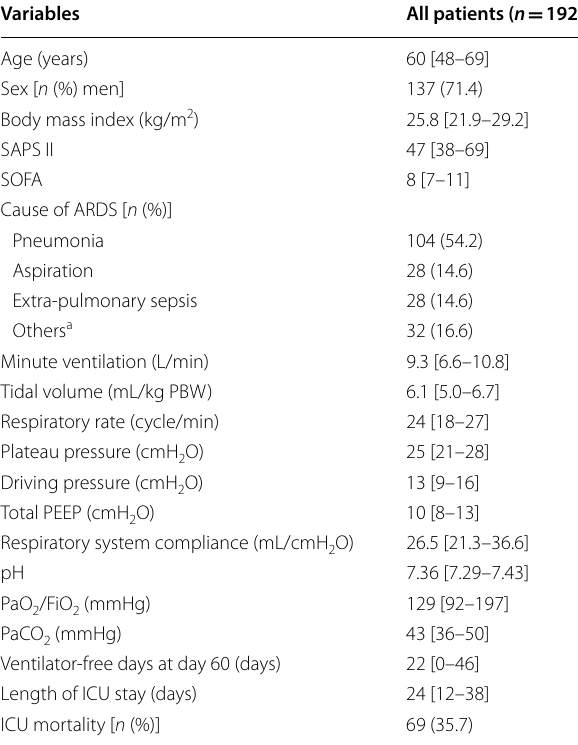
Table 1 Characteristics of the patients at ARDS onset Table 2 CT scan fibrosis scores according to lung